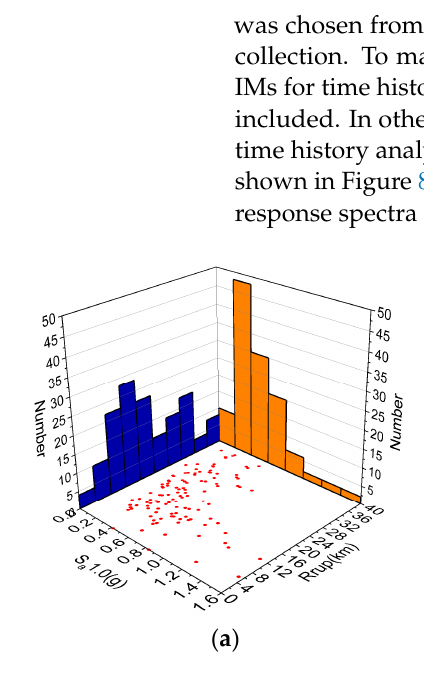
Figure 8. Information of selected earthquake records: ( a ) Sa1.0 and fault distance; ( b ) spectral acceleration.